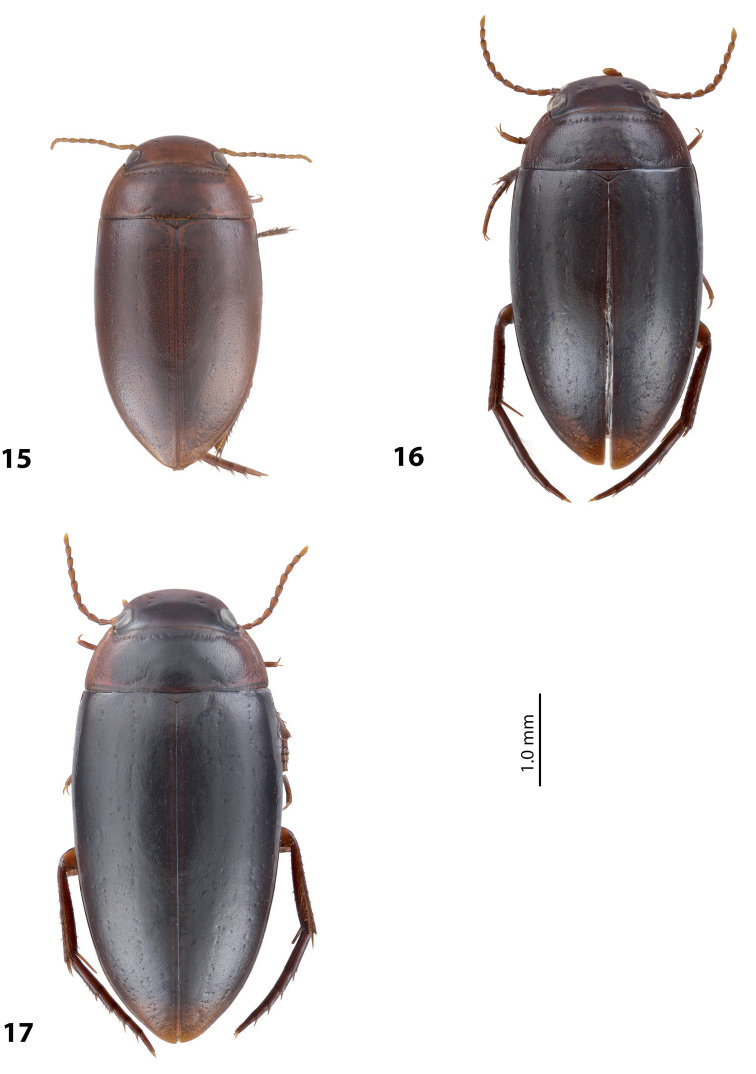
Habitus and coloration 15Exocelinadesii (Balke, 1999) 16E.heidiae (Balke, 1998) 17E.simbaijimi sp. n.